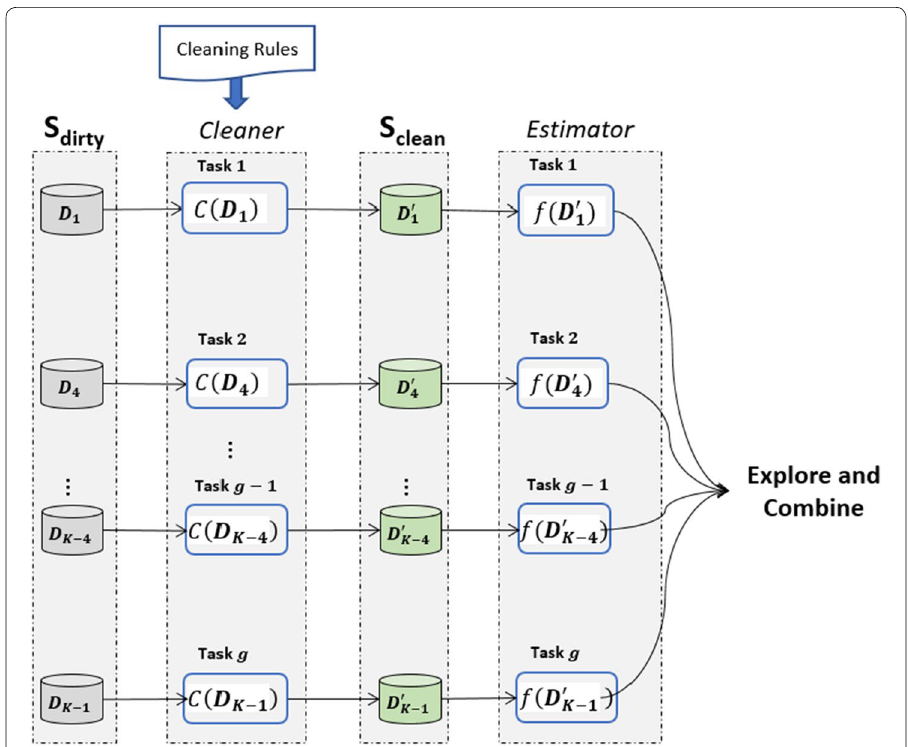
Fig. 3 Cleaning and estimation. Cleaning block-level samples of dirty RSP blocks to estimate statistics of the entire unknown clean